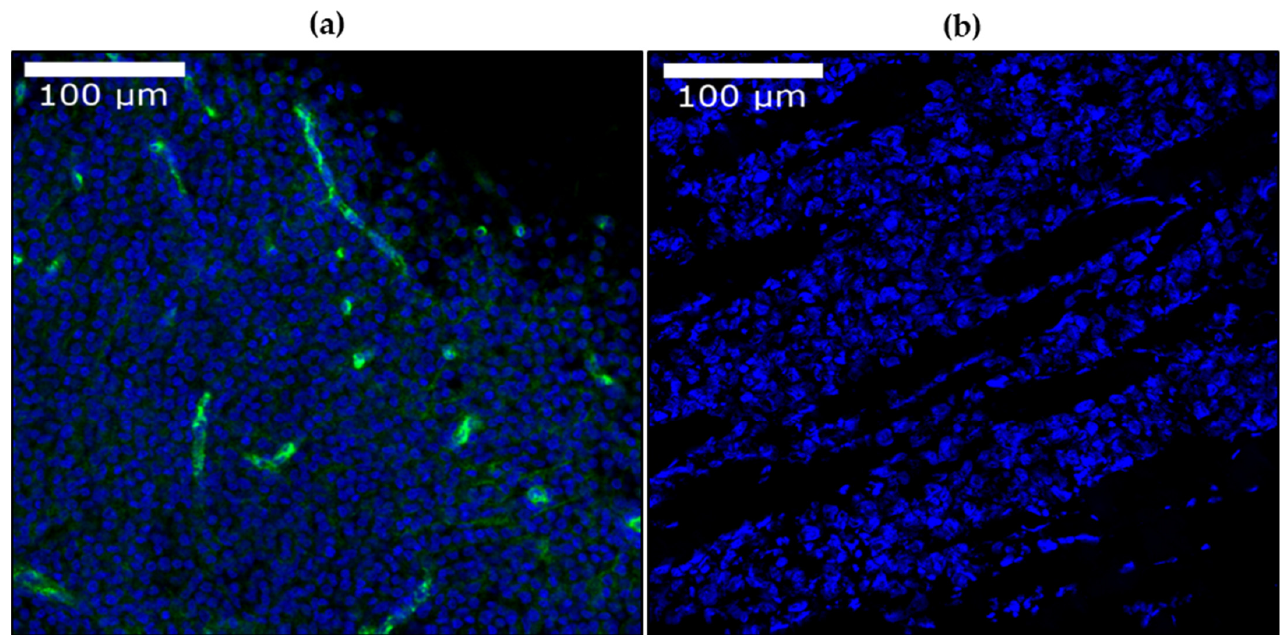
Figure 10. ( a ) Combined results of DAPI (blue) and Factor VIII (green) IHC labelling in CUBIC 1-A cleared human melanoma samples, 20× magnification with confocal microscopy. ( b ) DAPI (blue) IHC labelling in CUBIC cleared melanoma xenograft model, 20× magnification. The window/level was adjusted uniformly on all images for better visualization.